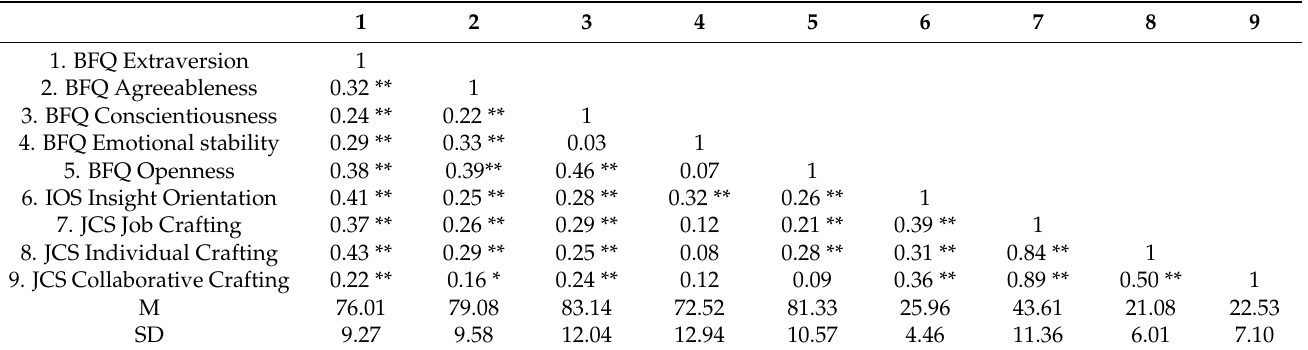
Table 1. Correlations among BFQ dimensions, IOS and JCS ( N =